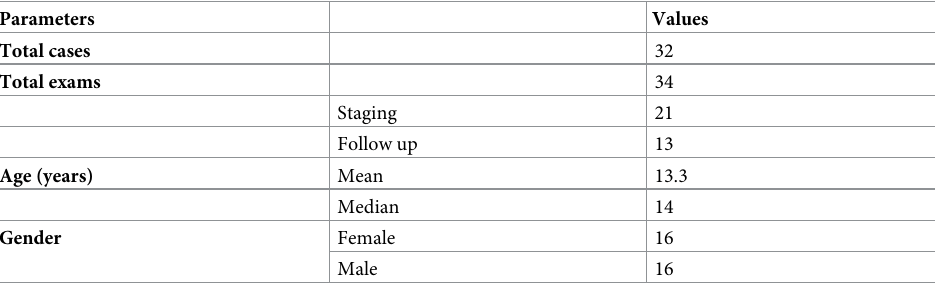
Table 3. Distribution according to